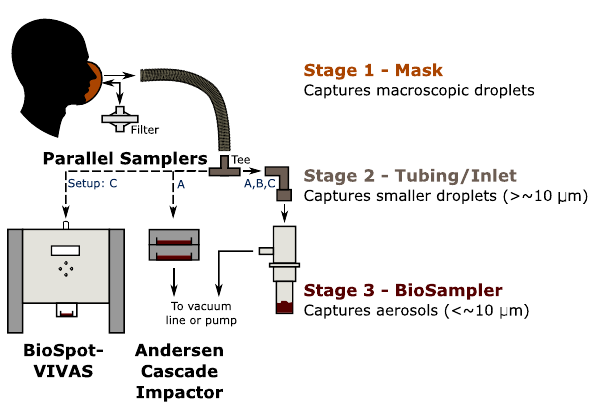
Figure 2. ( a ) Total number of SARS-CoV-2 gene copies per sample from study participants as a function of that found in the air sample gathered concomitantly using the BioSampler (RNA in bioaerosols ∼ 0.3–10 µ m in diameter; see Supplementary Sect. S3 for details), and ( b ) comparison of total gene copies per sample across the 13 participants (P05B–P17C) for whom NP swabs and samples from Stages 1 to 3 were collected. The small markers depict the results of each individual sample.